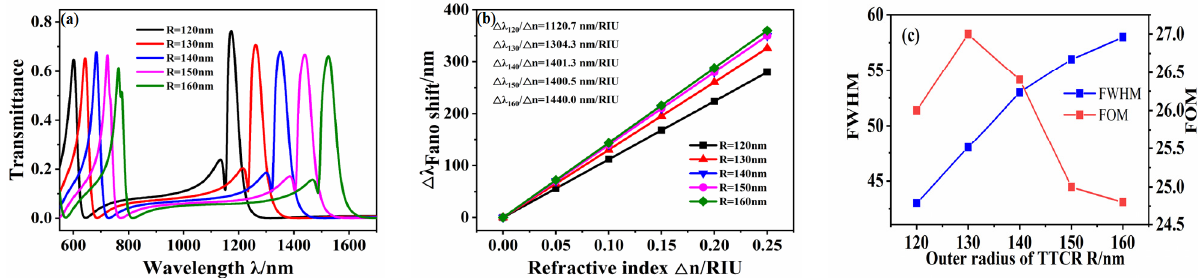
Figure 5. ( a ) Transmission spectrum of waveguide structure under different R . ( b ) Sensitivity fitting curve. ( c ) Fitting curve of FWHM and FOM values.